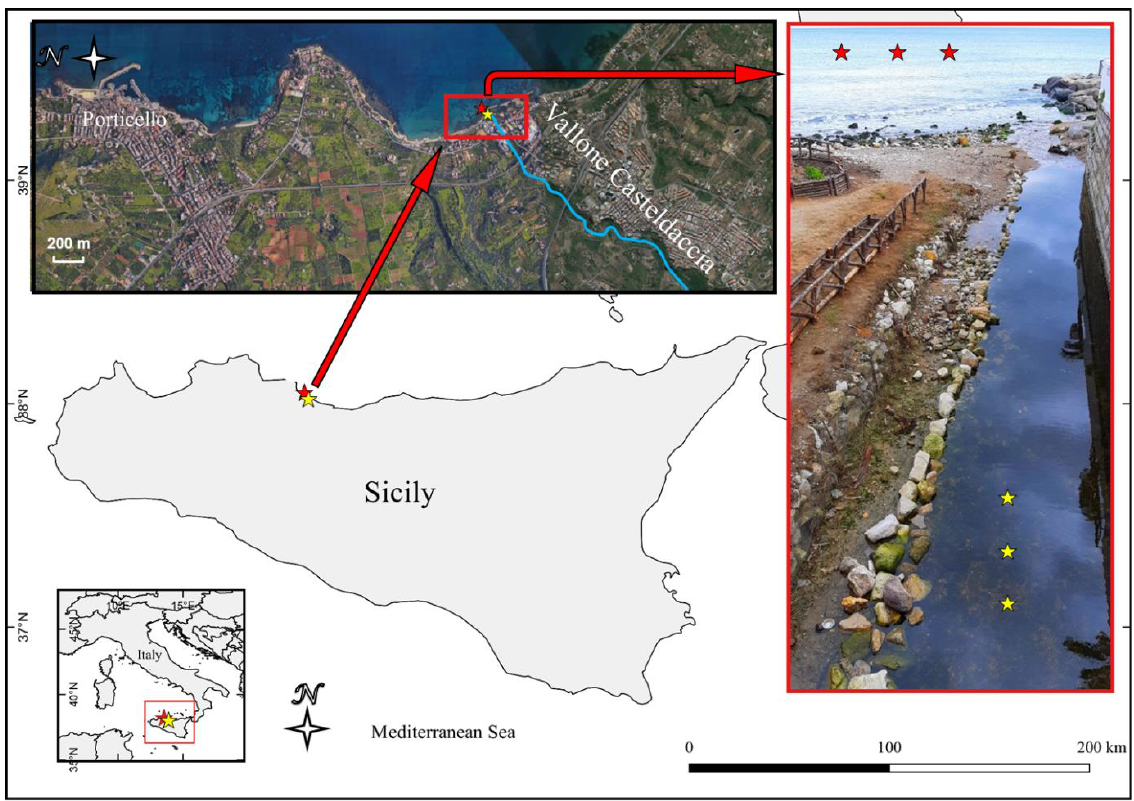
Figure 1. Map of the sampling site. Red asterisks indicate the sampling site of seawater and PE waste from the sea and the yellow ones the sampling site from the stream.